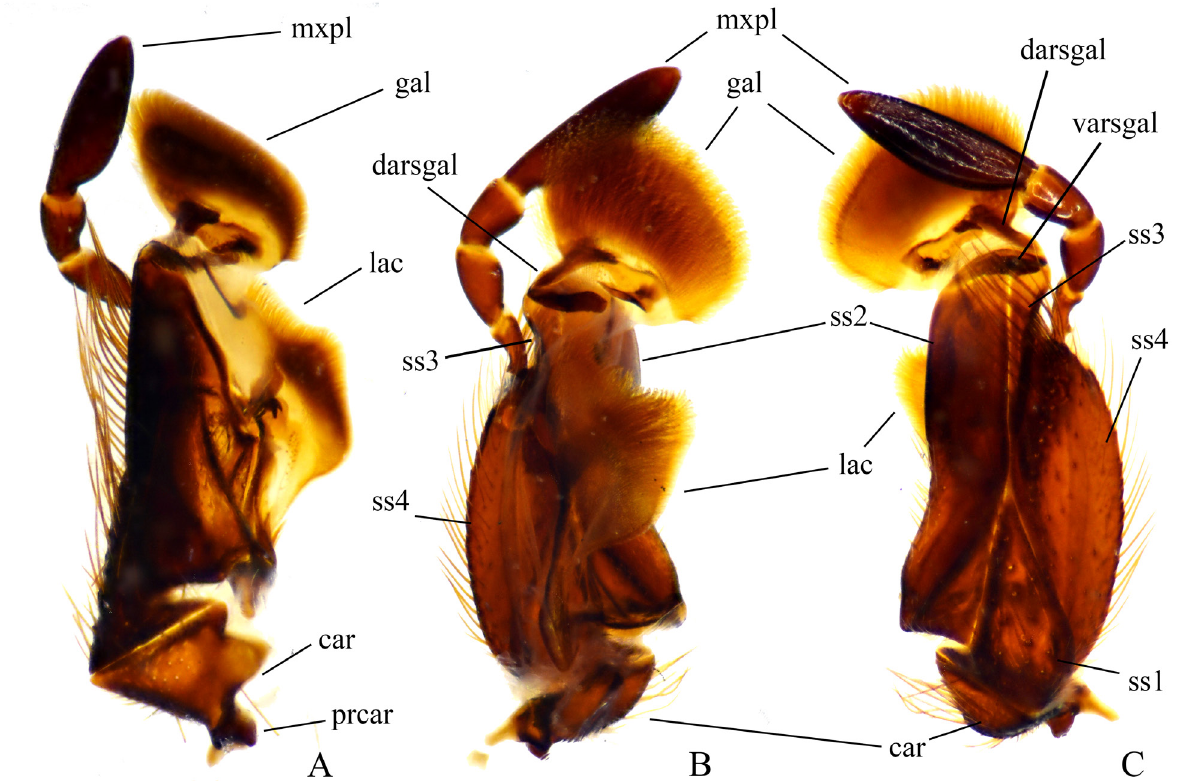
Fig. 10. Maxillae of Streblopus opatroides van Lansberge, 1874. A . Dorsal view with extended lacinia. B . Dorsal view. C . Ventral view. Abbreviations: car = cardo; darsgal = dorsal articular sclerite of galea; gal = galea; lac = lacinia; mxpl = maxillary palpus; prcar = articular process of cardo; ss1–4 = stipal sclerite 1–4; varsgal = ventral articular sclerite of